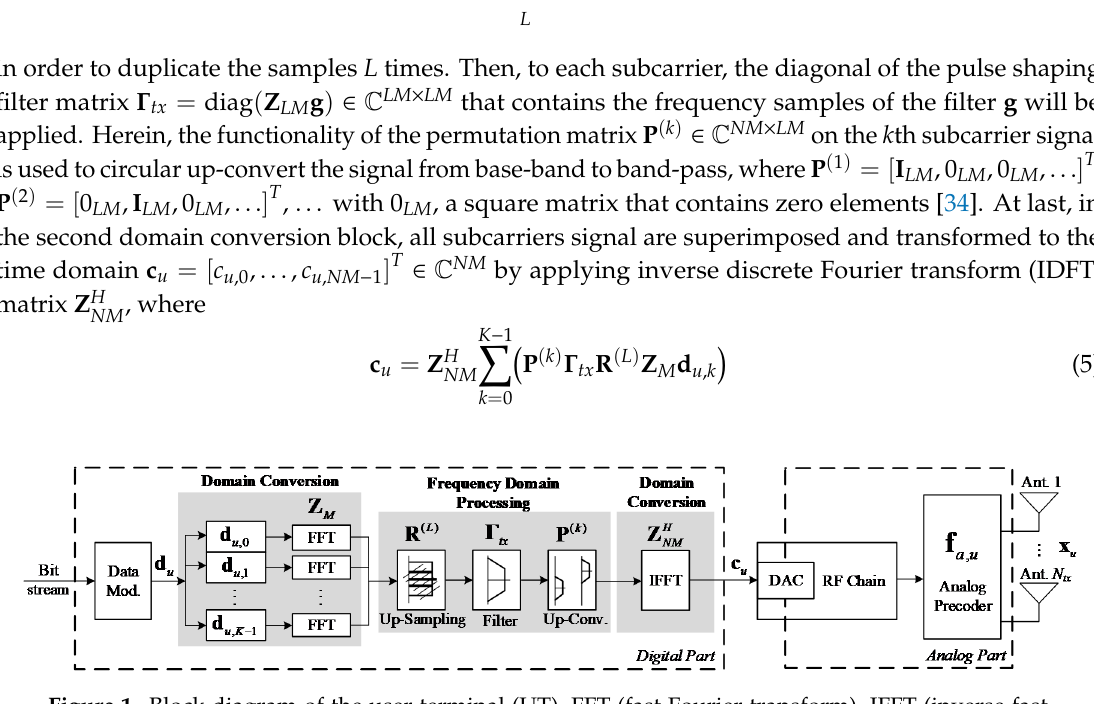
Figure 1. Block diagram of the user terminal (UT). FFT (fast Fourier transform), IFFT (inverse fast Fourier transform), DAC (digital to analog converter), RF (radio frequency).